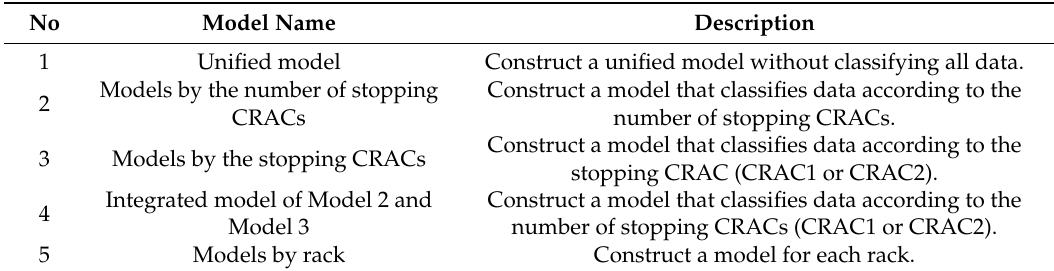
Table 5. Outline of each